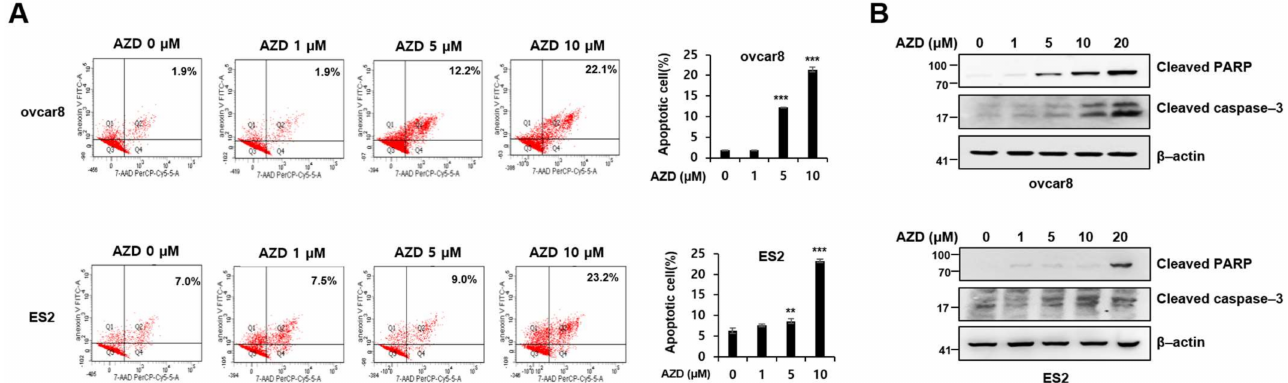
Figure 3. AZD4547 induces apoptosis in ovarian cancer cells. ( A ) Ovcar3 and ES2 cells were pretreated with AZD4547 (0, 1, 5, and 10 µ M) for 48 h and stained with annexin V and 7-AAD. Left panel, representative figures of three independent experiments. Right panel, quantification of the corresponding group. ( B ) Western blot analyses of AZD4547-treated ovcar8 and ES2 cells. AZD, AZD4547. ** p < 0.01, *** p < 0.001.